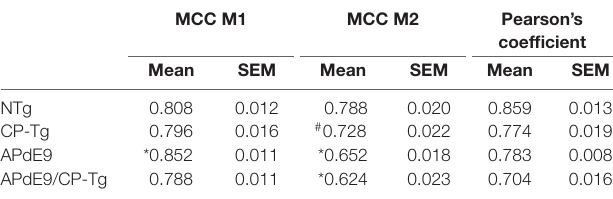
TABLE 1 | Effect of PGIS overexpression on colocalization of microvessels and pericytes. MCC M1 MCC M2 Pearson’s coefficient Mean SEM Mean SEM Mean